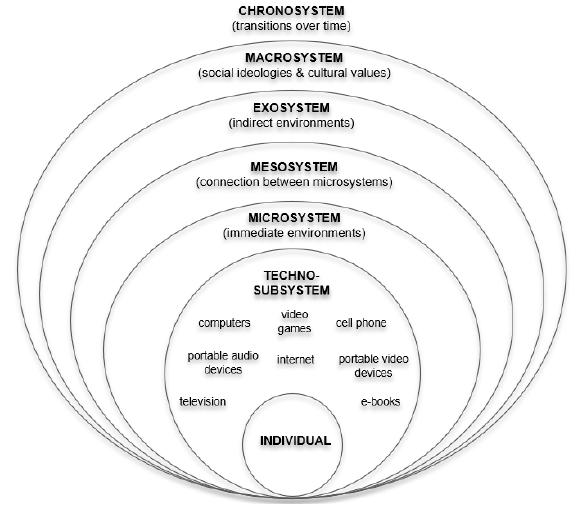
Figure 1. Ecological Techno-Subsystem.